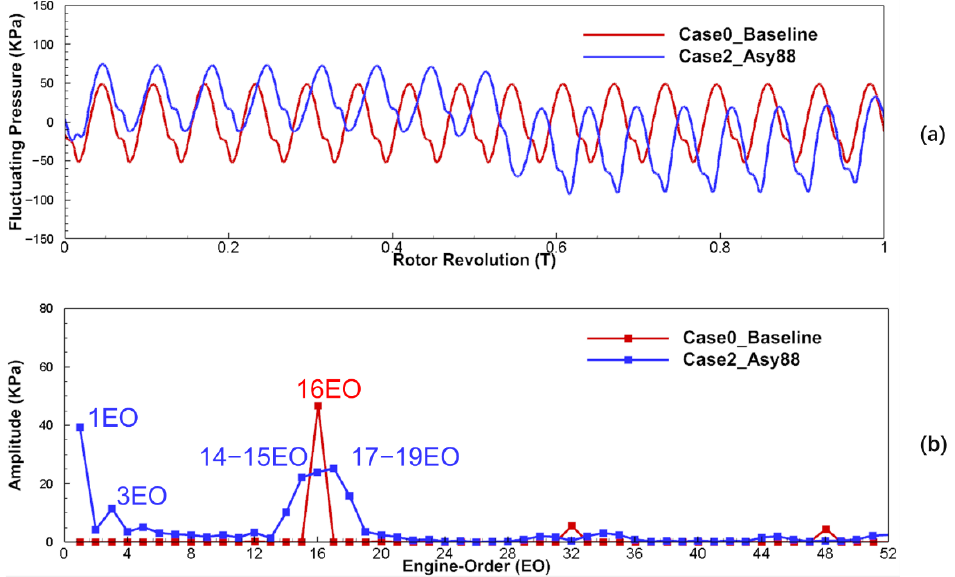
Figure 18. ( a ) Time histories of the fluctuating pressure at monitoring point P; ( b ) Frequency spectra of fluctuating pressure at monitoring point P.